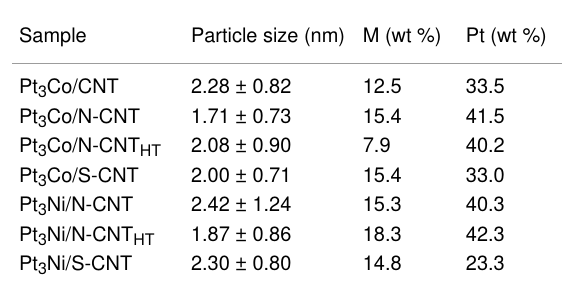
Table 3: Mean nanoparticle size and metal loading for PtM/CNT cata- lysts.